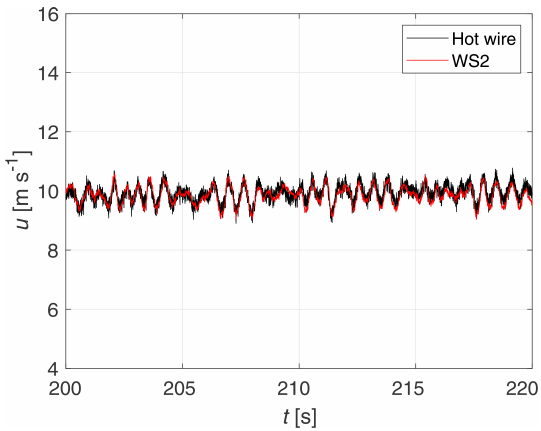
Figure 7. Snapshot of the 10min time series measured by Wind- Scanner 2 and the hot-wire anemometer for a turbulence intensity of 3% (Case 1a).